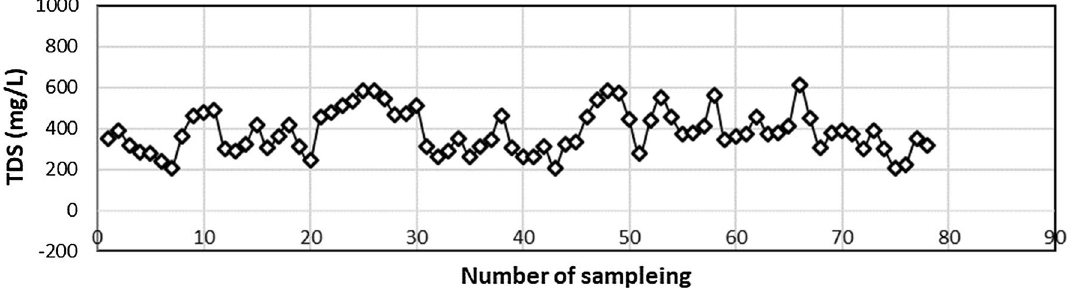
Fig. 2 Evaluating the TDS of product water for 78 sampling time in period of 1